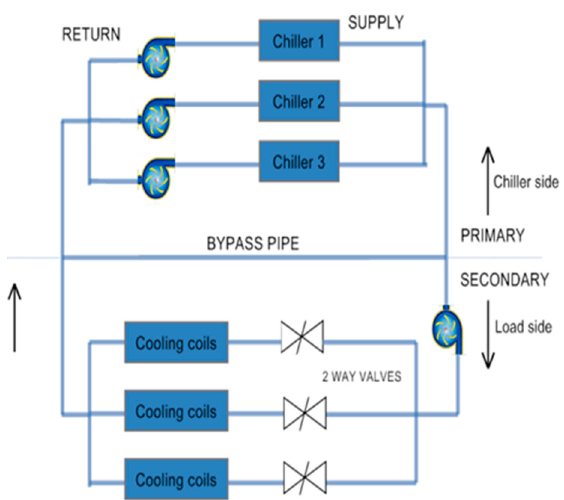
Figure 1. Multi-chiller system architecture.